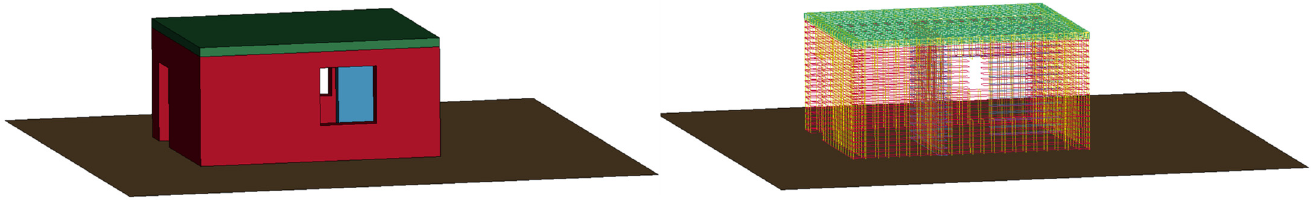
Figure 3. Details of the complete 3D model made with LS ‐ DYNA and details of the steel armor.